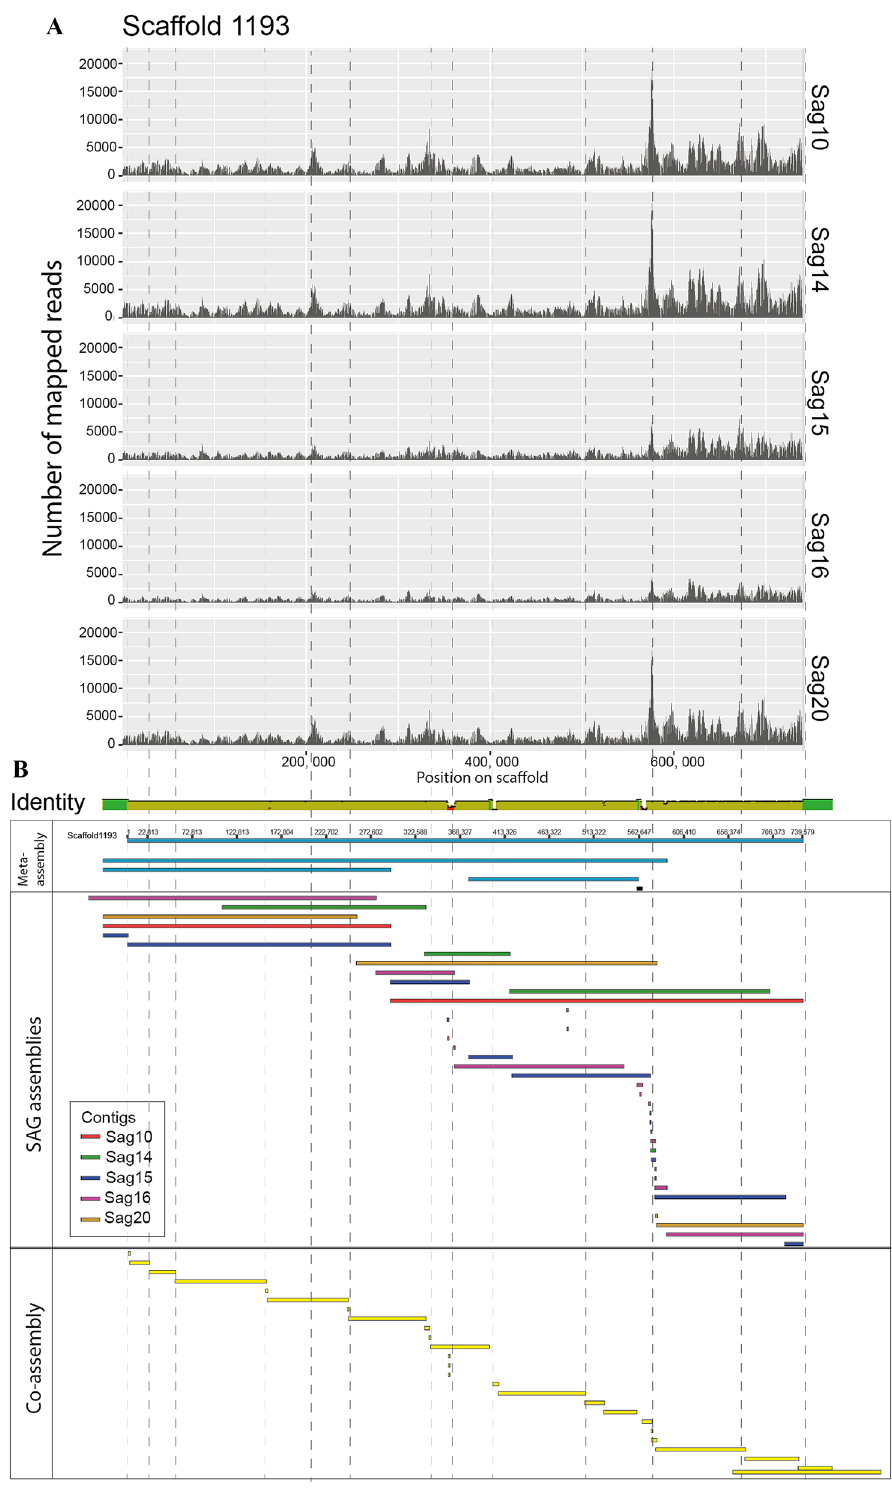
Figure 5. Genome coverage and alignment of contigs to scaffold 1193 in the meta-assembly. ( A ) Mapped Illumina reads from each SAG library to scaffold 1193 from the meta-assembly. ( B ) An alignment of the contigs from the individual SAG assemblies and the contigs from the co-assembly against scaffold 1193. Vertical lines align the peaks in coverage from panel ( A ) to breakpoints in contigs of the co-assembly in panel ( B ). Plots created with the ggplot2 42 R package and Geneious Prime 2019.2 (www. genei ous.